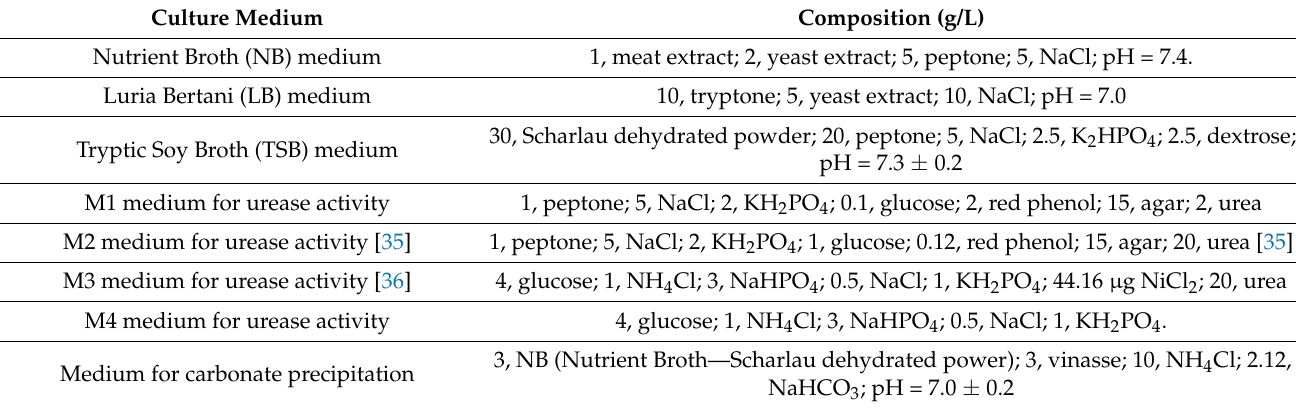
Table 1. Different media for the cultivation of